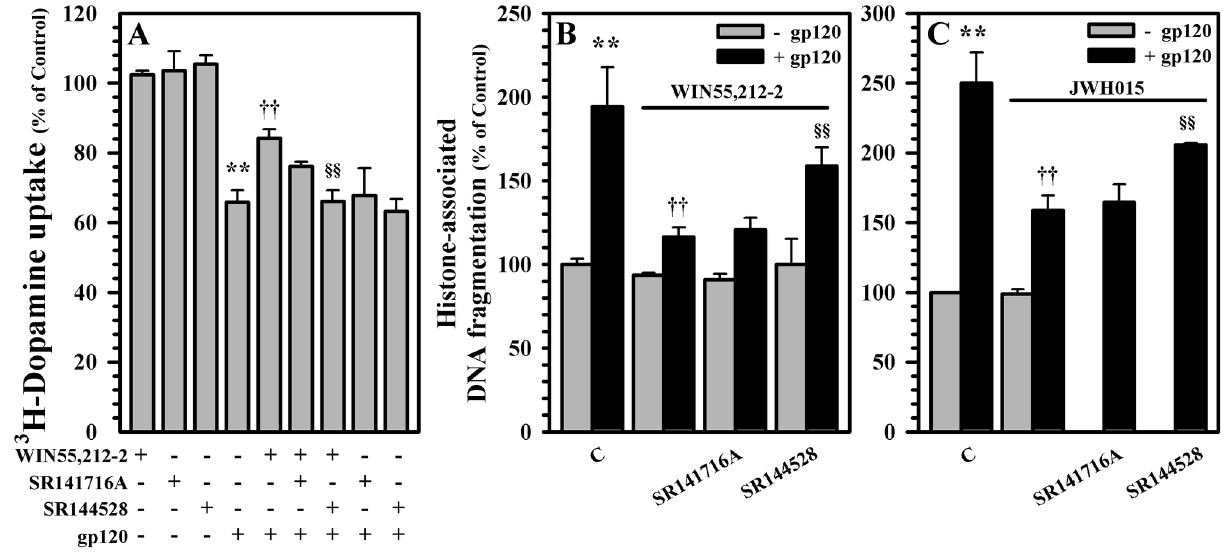
Figure 4. Involvement of cannabinoid receptors in gp120-induced suppression of DA uptake and apoptosis. Human mesencephalic neuronal/glial cultures were untreated (C) or pretreated with SR141716A (CB antagonist) (1 μM) for 30 min prior to WIN55,212-2 (0.3 μM) or JWH015 (CB nM) treatment for 5 days to measure A ) 3 H-DA uptake and B , C ) apoptosis by cell death ELISA. Data are mean ± SEM of